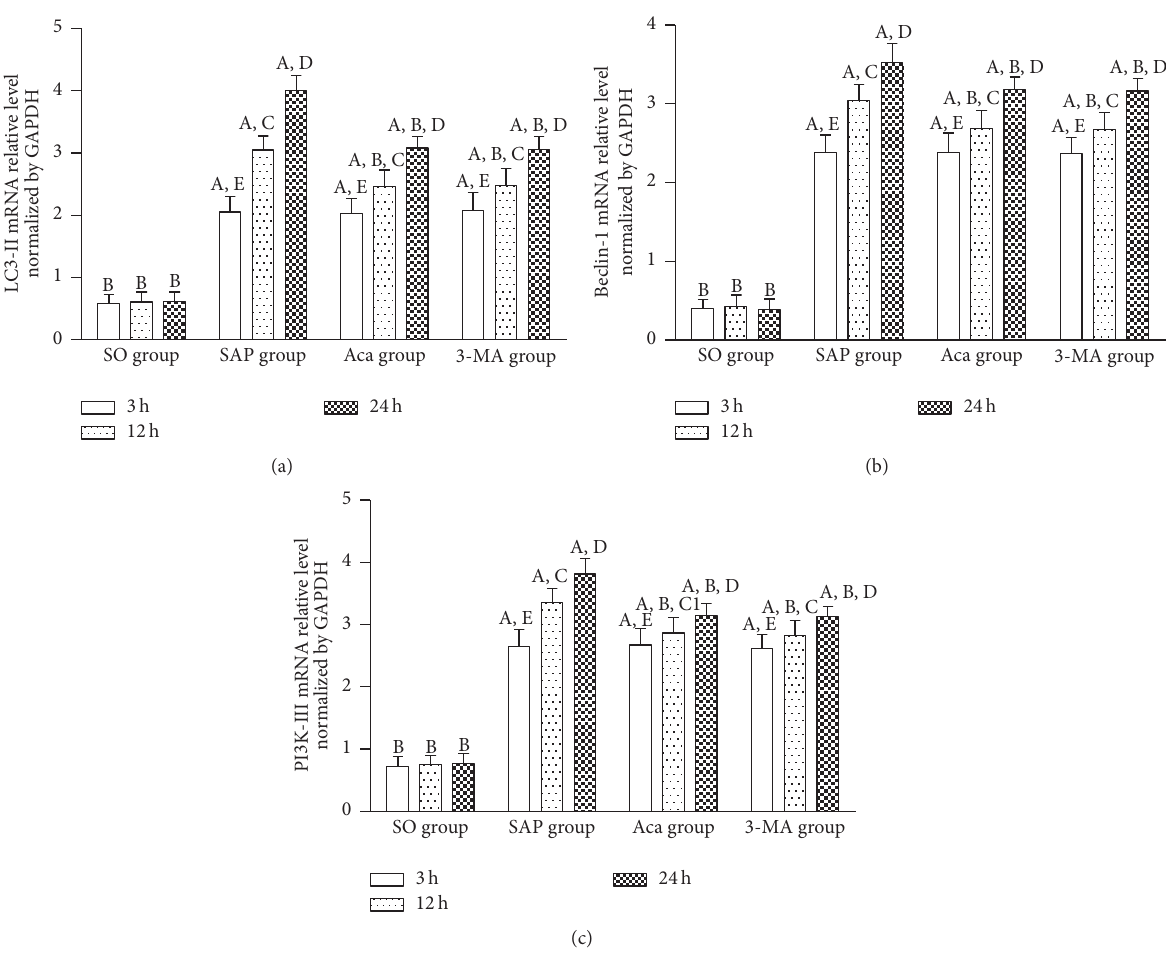
Figure 4: The mRNA levels of LC3-II (a), Beclin-1 (b), and PI3K-III (c) in the pancreas tissue at 3, 12, and 24 h in four groups. A 𝑃 < 0.01 versus SO group at the same time point; B 𝑃 < 0.01 versus SAP group at the same time point; 12h versus 3h in the same group, C 𝑃 < 0.01 , C 1 𝑃 < 0.05 ; 24 h versus 12h in the same group, D 𝑃 < 0.01 ; 24 h versus 3 h in the same group, E 𝑃 < 0.01